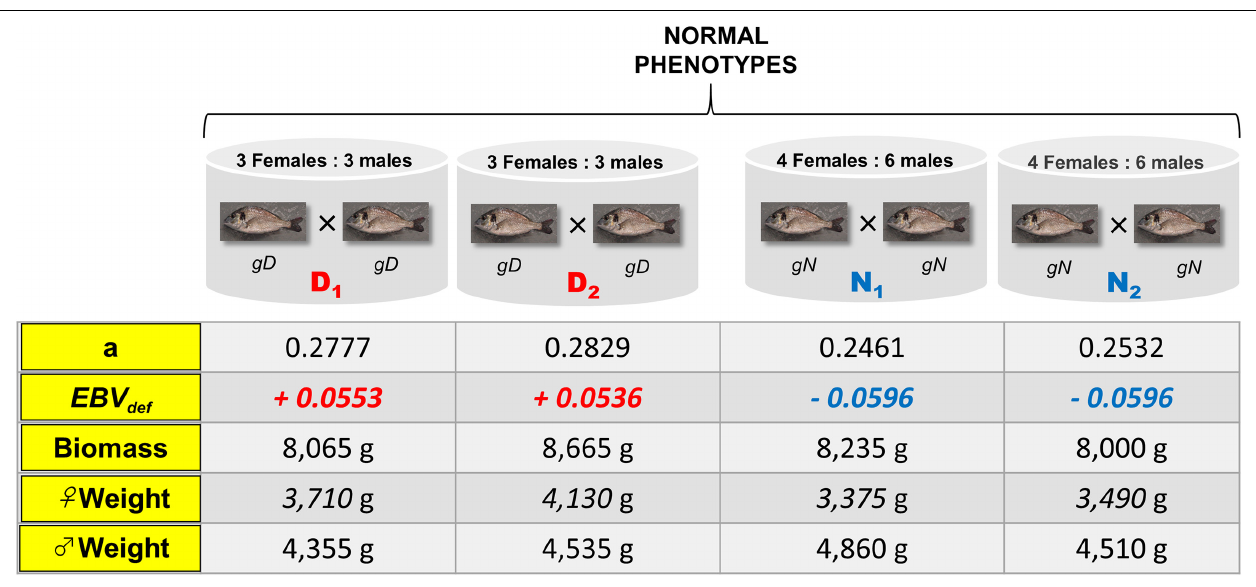
FIGURE 2 | Experimental design representation that shows the two genetic groups (genetically deformed, gD; genetically normal , gN) with their duplicates (D 1 , D 2 and N 1 , N 2 ), the number of breeders per tank and their data: kinship (a), estimated breeding value for the presence or absence of deformity at commercial size (EBV def ), biomass, female weight ( weight), and male weight ( ♀ ♂